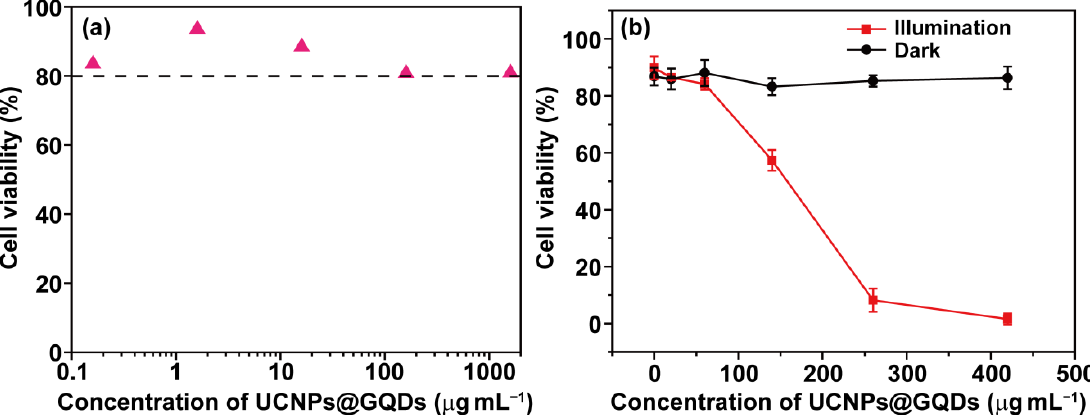
Figure 4. PDT assessment for UCNPs@GQDs. ( a ) Biocompatibility of UCNPs@GQDs was assessed without irradiation of a 980 nm laser. ( b ) Cell viability of HeLa cells treated by UCNPs@GQDs was determined by Live/Dead assay kit.